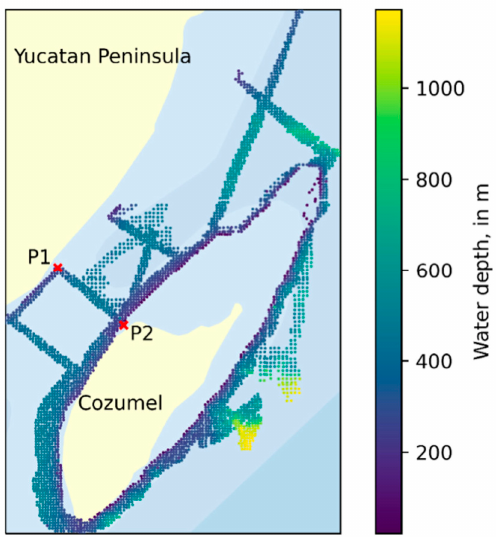
Figure 6. Bathymetric Survey carried out in the CEMIE ‐ O 1 research expedition, April 2019. Background data from Natural Earth.